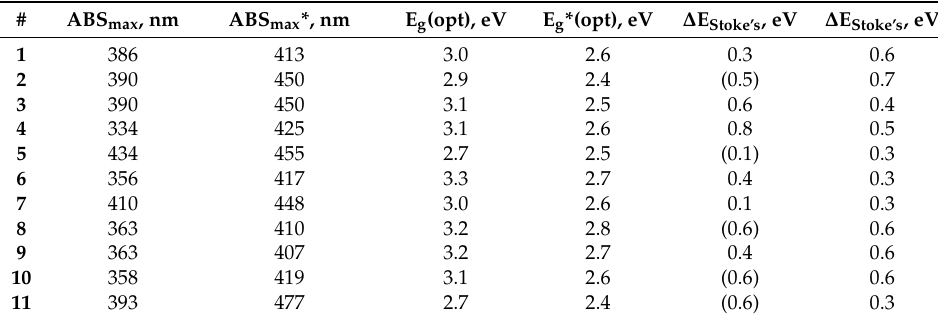
Table 1. Main optical parameters of the